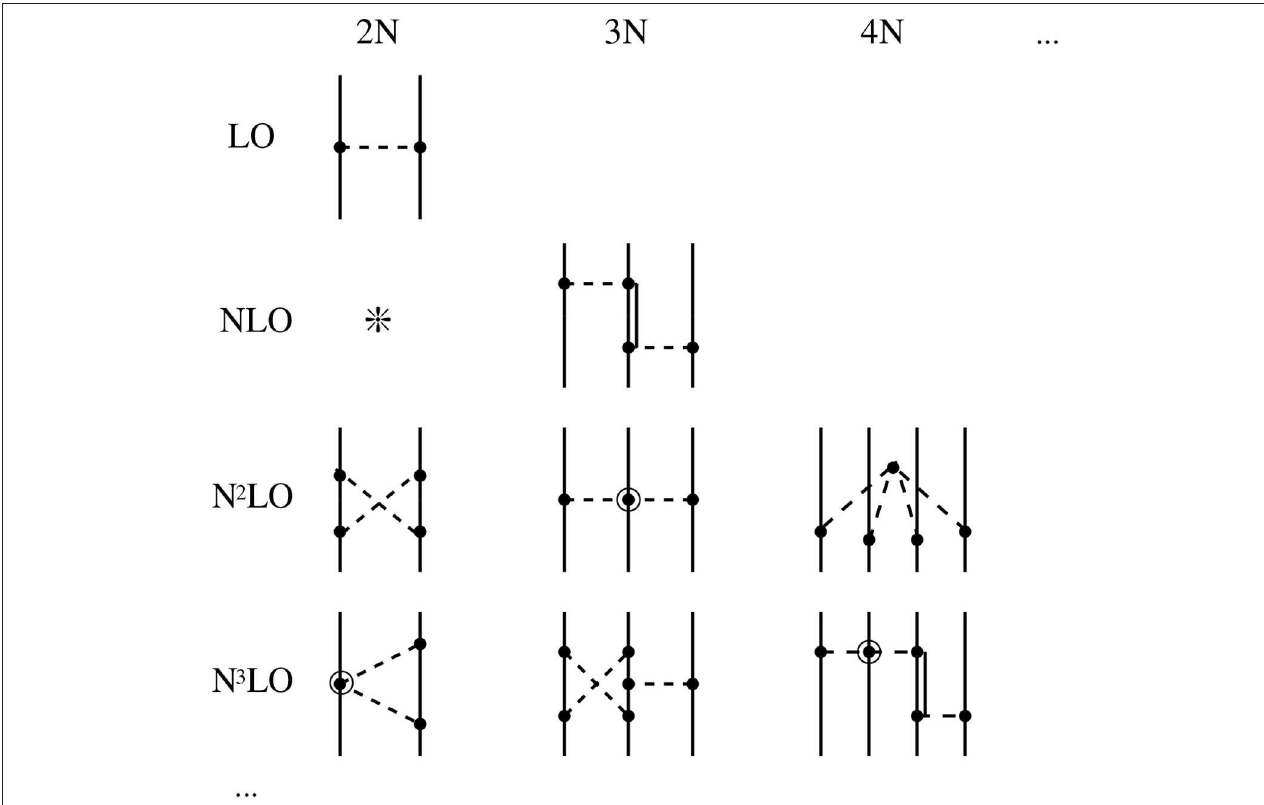
FIGURE 2 | Sample of pion-range diagrams in the aN nuclear potential ordered according to the expected size of their contributions to the amplitude (Equation 12). N ν LO denotes relative O ( Q ν / M ν QCD ). A solid (double) line stands for a nucleon (nucleon excitation), while a dashed line, for a pion. A circle (circled circle) represents an f / 2 interaction with d 2 0 ( + − = =